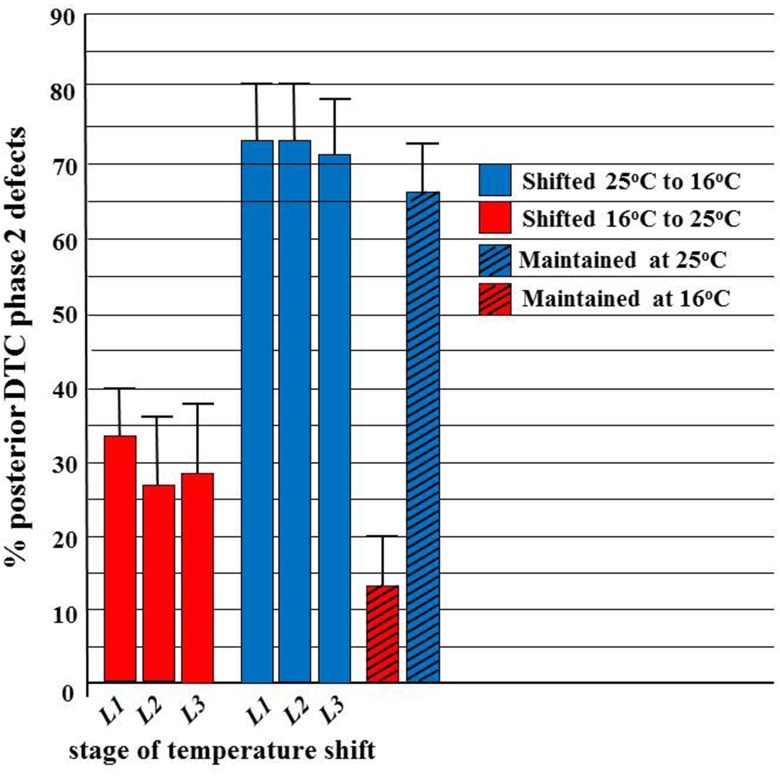
Approximate ts period for the ev821 phase 2 DTC navigation errors.ngat-1(ev821) animals were grown at 16°C or 25°C then shifted to test temperature (25°C or 16°C, respectively) at various larval stages of development (L1, L2, and L3). Control animals were maintained at 16°C or 25°C test temperature throughout the experiment. Animals were scored by D.I.C. microscopy in the 4th larval stage (L4) or as young adults for phase 2 posterior DTC migration errors. A temperature-sensitive period was readily identified for these defects, which was developmentally much earlier than manifestation of the late L3 stage phase 2 DTC migration defect. Error bars represent z-test based 95% confidence intervals.